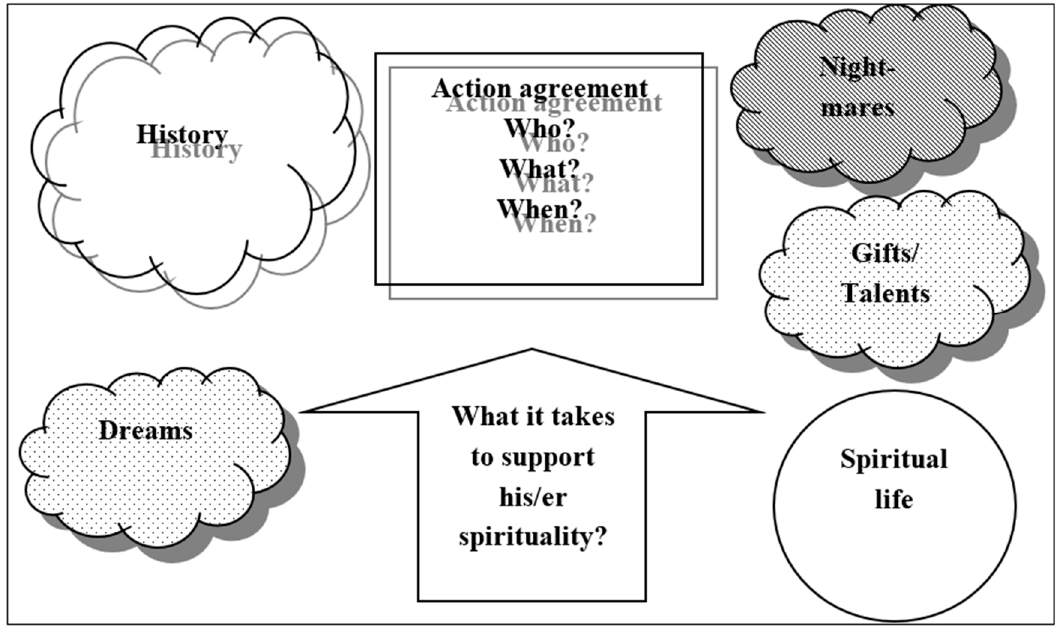
Figure 3. Key components of the spiritual MAPS.